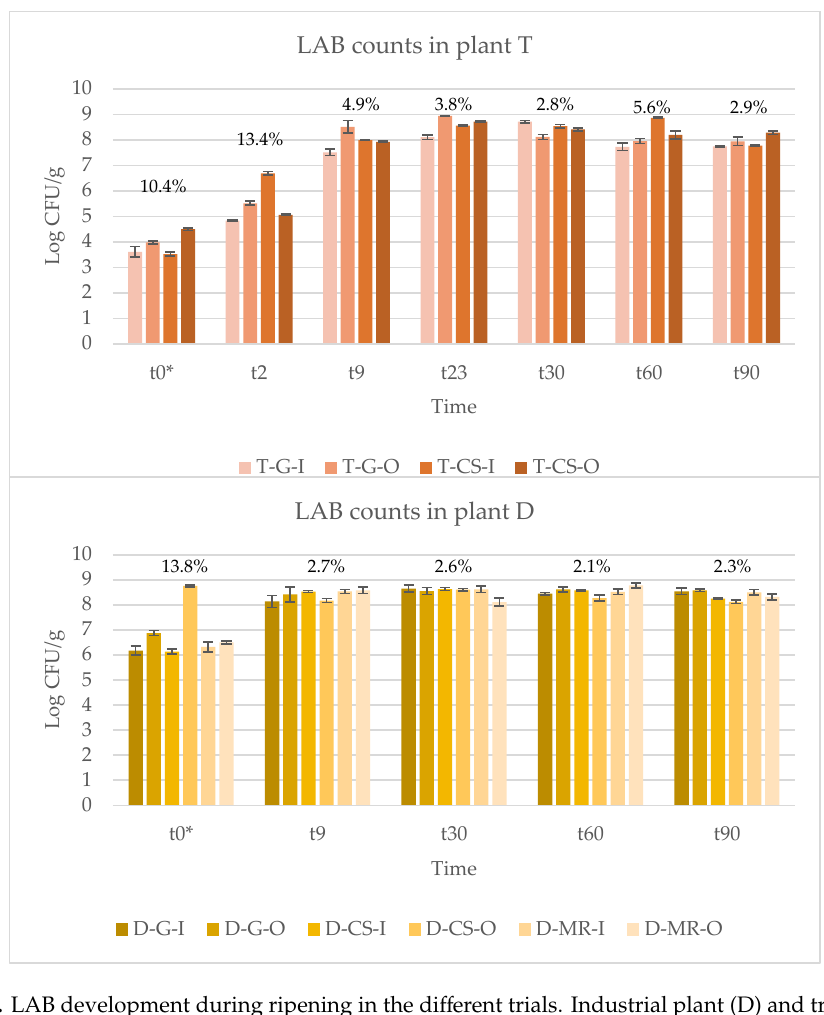
Figure 1. LAB development during ripening in the different trials. Industrial plant (D) and traditional plant (T) whose meats derived from pigs of three breeds, Goland (G), Cinta Senese (CS), and Mora Romagnola (MR) that were indoor (I) or outdoor (O) housed. The coefficient of variation among trials per time is shown above histograms.